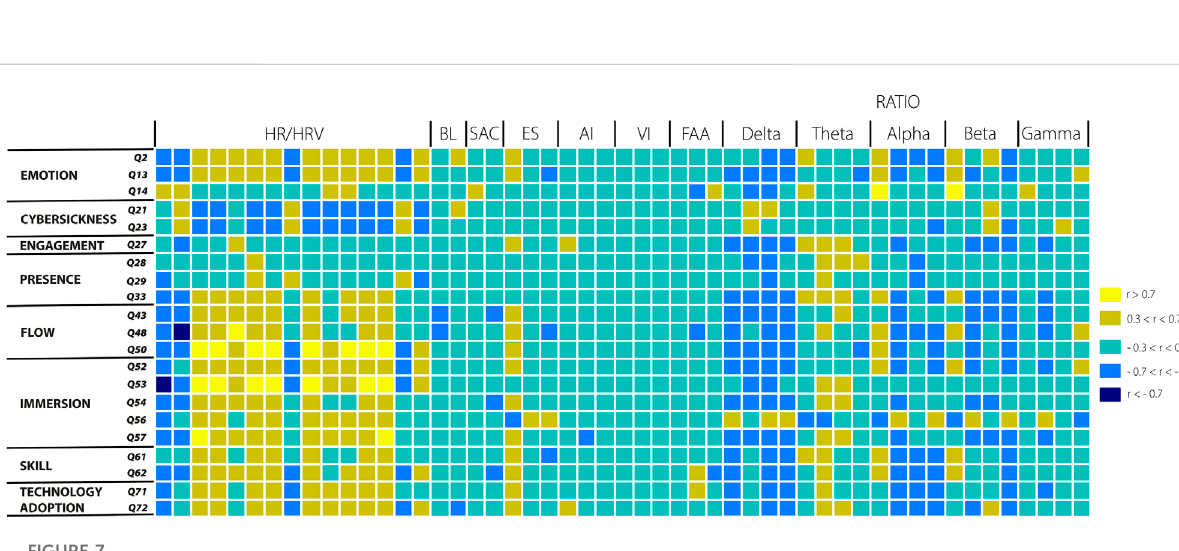
FIGURE 7 List of metrics that showed correlation with each subjective